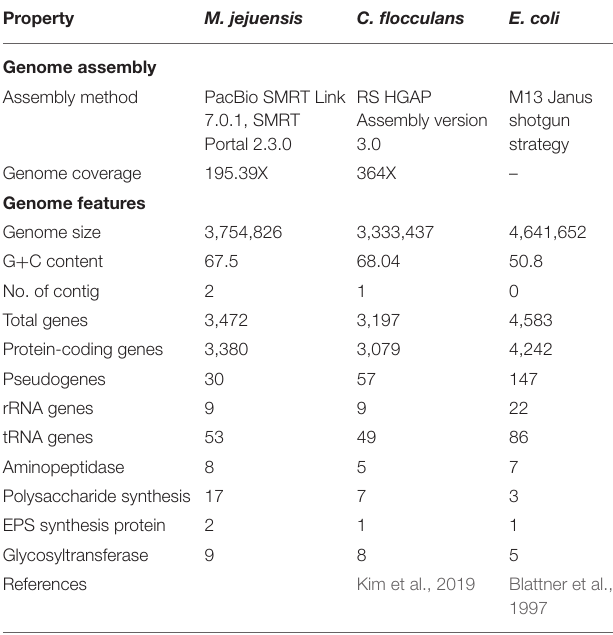
TABLE 1 | General characteristics of M. jejuensis , C. flocculans , and E. coli , including flocculation-related genes.